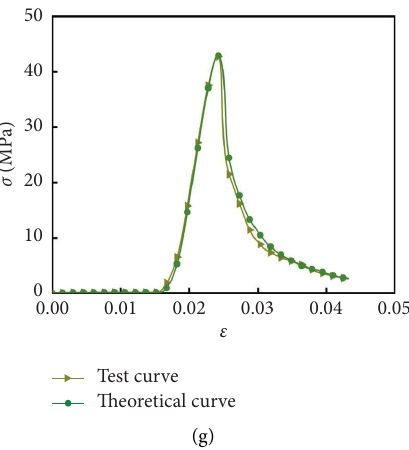
Figure 9: Comparison curve of LAC. (a) OC group. (b) BF-0.1 group. (c) PF-0.1 group. (d) HC-0.1 group. (e) HC-0.2 group. (f) HC-0.3 group. (g) HC-0.4 group.